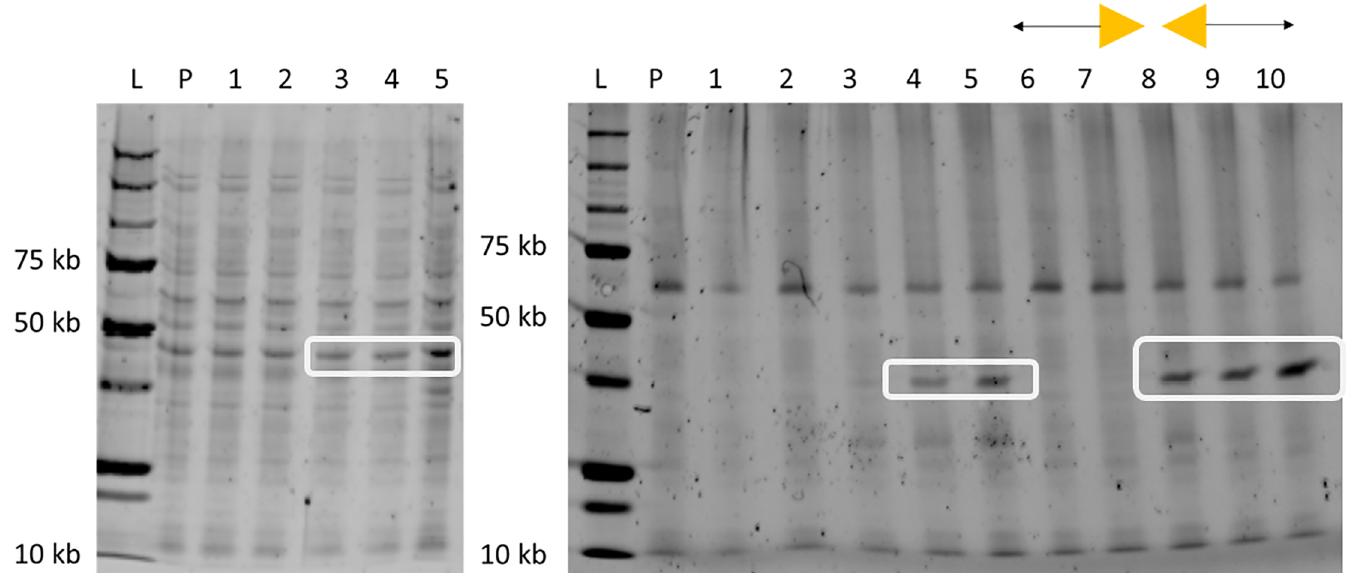
Fig 6. SDS PAGE of V . cholerae . (A) V . cholerae conventionally heating and microwave irradiated. L: Ladder, P: Pre-Lyse V . cholerae . Left: Conventionally heating. Lanes 1–5: 40˚C—80˚C, Right: Microwave irradiated. Lanes 1–5 No Lyse-It 1 10–50% power, 60 seconds respectively. Lanes 6–10: Lyse-It 1 10–50% power, 60 seconds respectively. Highlighted regions demonstrate that more protein is released with Lyse-It 1